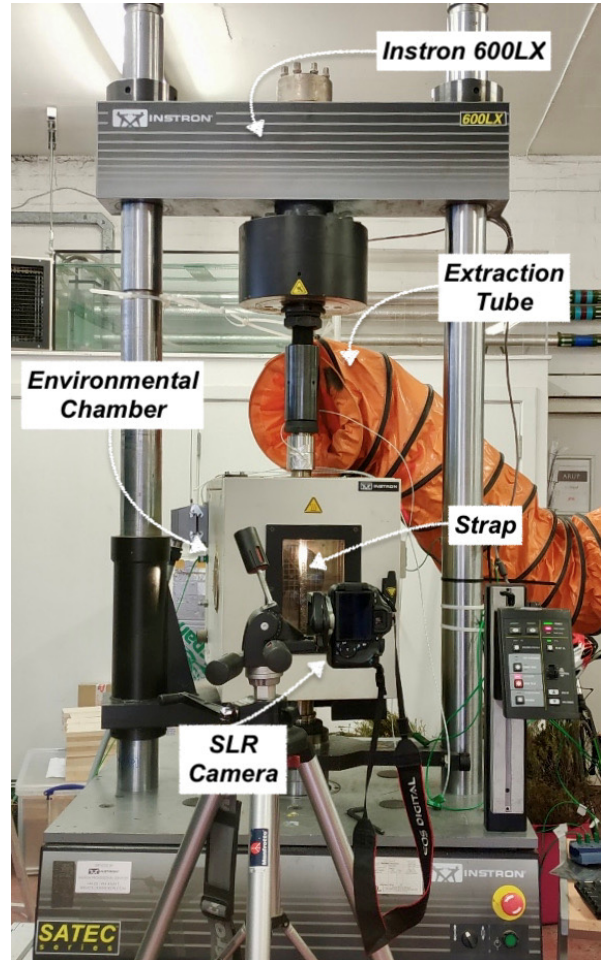
Figure 16. Ambient and elevated temperatures test set-up. In the SS experiments, the straps were initially loaded using a load hold mode at 0.5 kN tensile load until the target temperature was reached. The straps remained at the target temperature for a further 10 min to ensure an even distribution of temperature in the pin-strap system. After 10 min, the hold mode was switched to displacement control mode and the straps were loaded at a displacement rate of 2 mm/min until failure; five tests were performed for each temperature. The eight target temperatures selected were: 24 ◦ C (ambient), 100 ◦ C, 140 ◦ C, 280 ◦ C, 320 ◦ C, 400 ◦ C, 500 ◦ C, and 600 ◦ C. The choice of target temperatures was based upon the TGA samples tested in air, and aimed for those temperatures where mass loss was more pronounced and/or transition regions. A representative curve for an air exposed TGA sample, with the target testing temperatures also denoted, is given in Figure 18. For the TS cases, the straps were loaded with displacement control and a rate of 2 mm/min until the target load (10 kN, 15 kN, or 20 kN) was reached. The specified load level was maintained constant under load control while the temperature was increased up to 600 ◦ C, or until failure. For each TS case, three tests were performed. In both SS and TS tests, the heating rate was 10 ◦